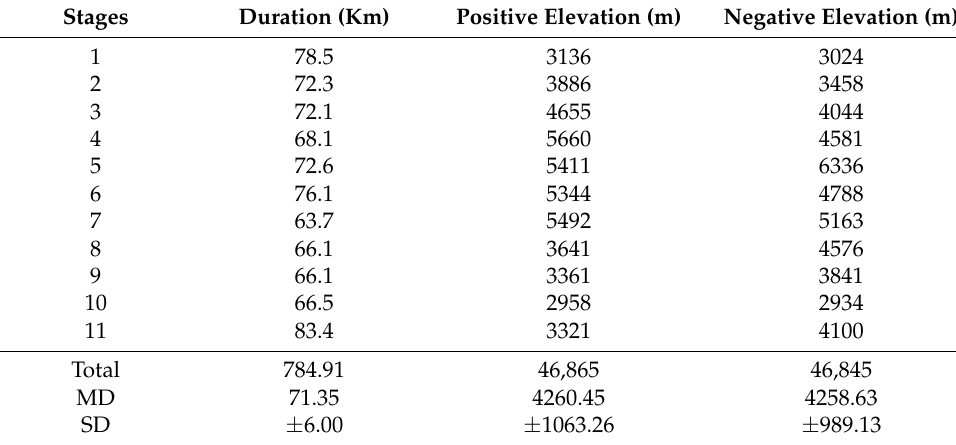
Table 2. Characteristics of the extreme